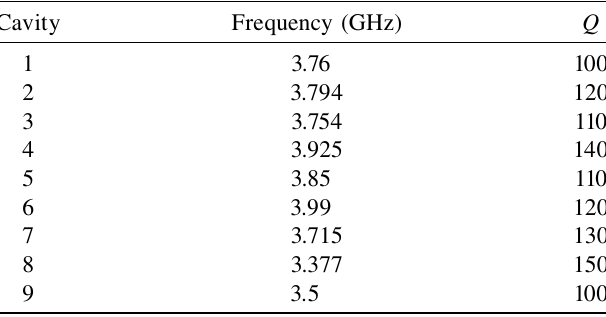
TABLE I. Pillbox cavity dipole mode parameters.